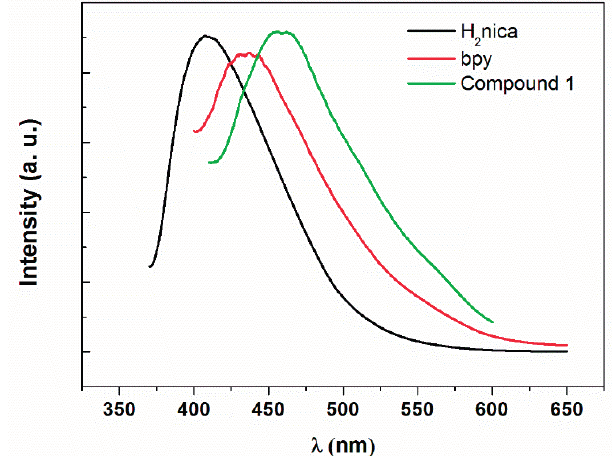
Figure 4. Emission spectra of 1 compared with the